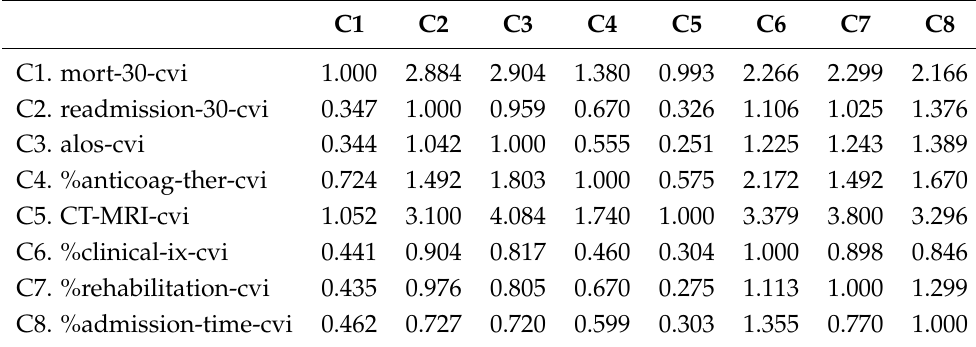
Table 7. Group pairwise comparison matrix for the cerebrovascular insult (CVI).